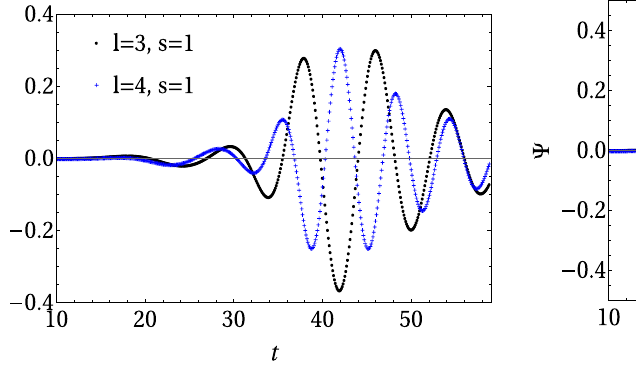
Fig. 12 Variation of ψ in linear scale with t for q = 0 . 2, (cid:2) = 0 . 0005